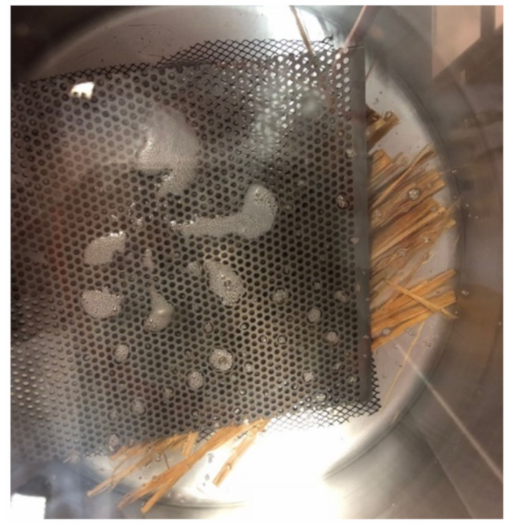
Figure 9. Bubble formation in the silicone chamber due to vacuum pressure